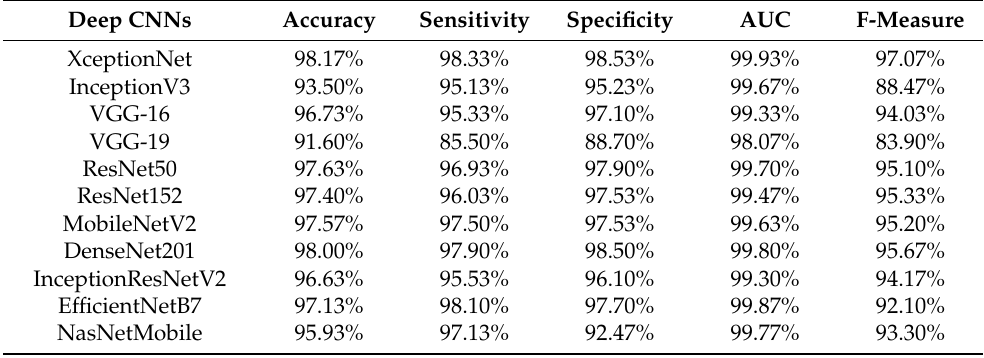
Table 5. Classification results of normal, pneumonia and COVID-19 using cropped lungs and 11 CNNs with Weighted Loss (Approach